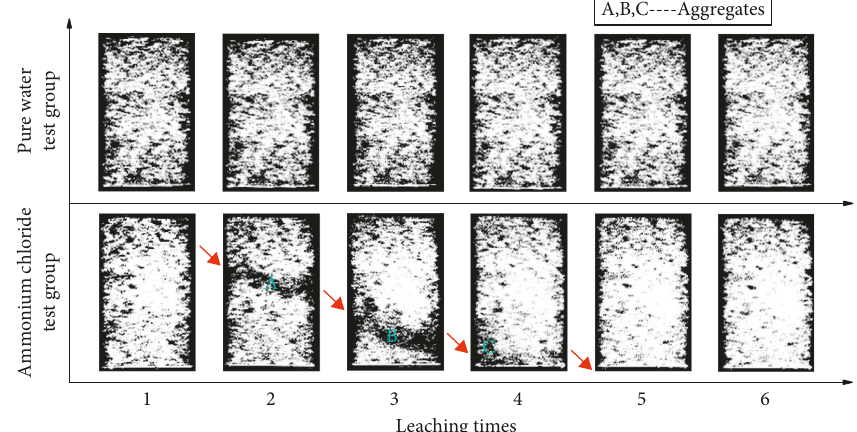
Figure 5: Inversion images of the sample during the column leaching